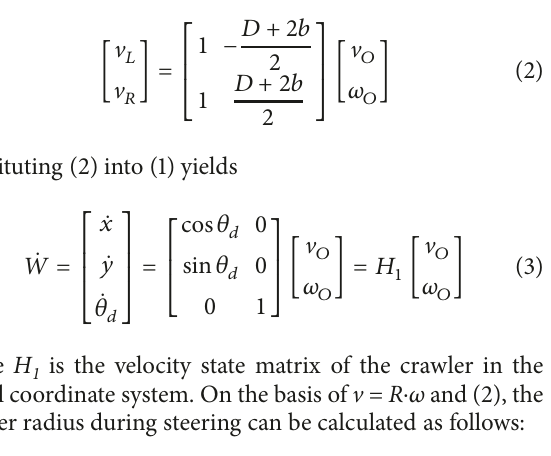
Figure 2: Turning diagram.